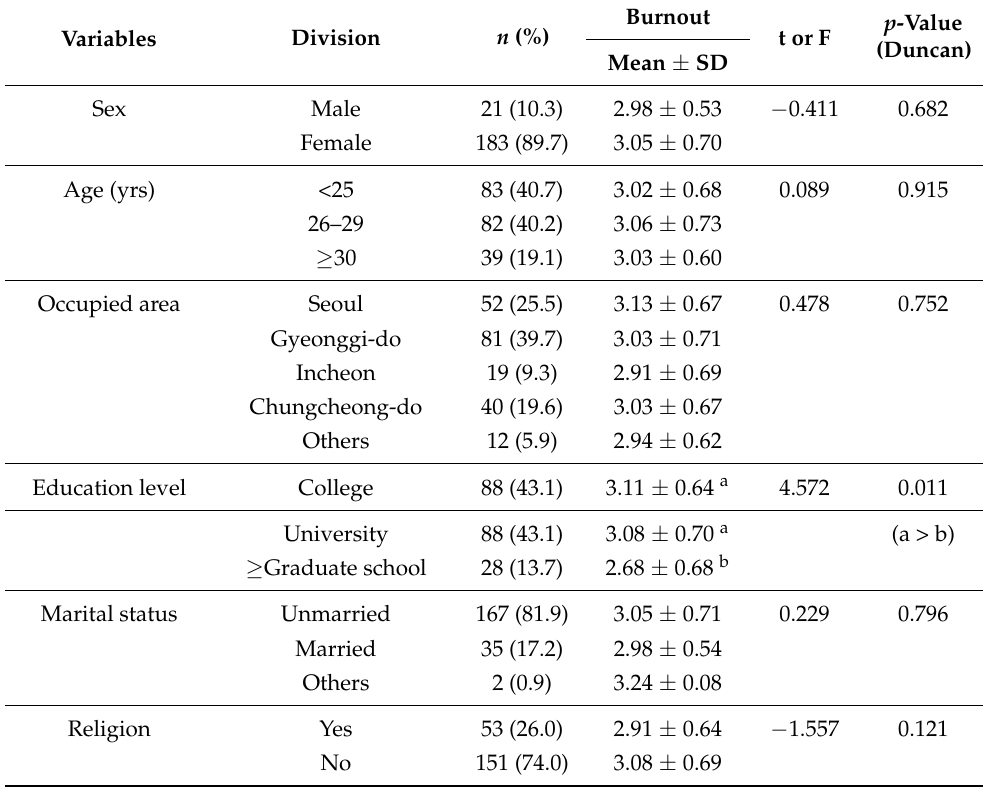
Table 1. Burnout according to the general characteristics of dental hygienists.